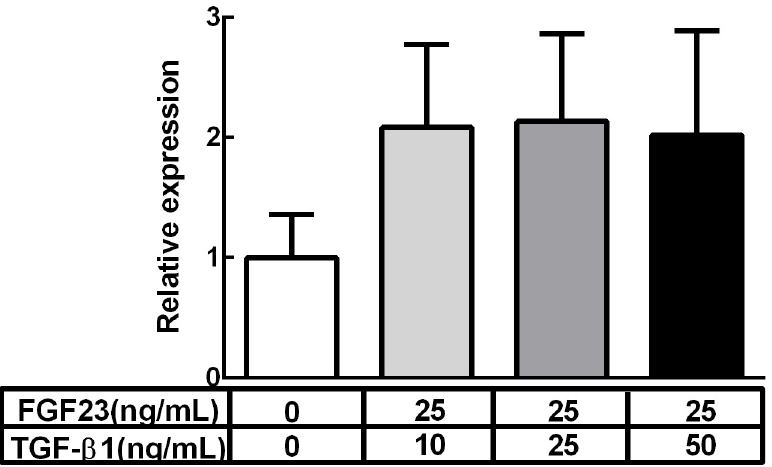
Fig 4. α -SMA mRNA expression levels in fibroblasts treated with FGF23 and various doses of TGF- β 1. Relative α - SMA mRNA expression levels 3 days after treatment with a combination of 25 ng/mL FGF23 and various doses of TGF- β 1 as measured by RT-PCR. Values are means ± SEM. n = 5 for